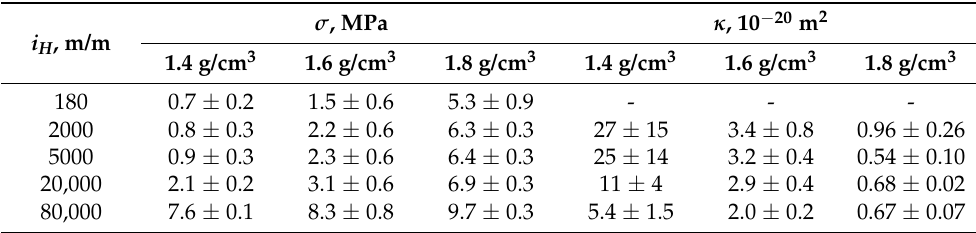
Figure 5. Total pressure at tops of permeameter cells for 10X specimens compacted to dry densities of 1.4 g/cm 3 (A1–A3), 1.6 g/cm 3 (B1–B3), and 1.8 g/cm 3 (C2, C3) and permeated by SGW at a hydraulic gradient of 80,000 m/m. Real fluid injection pressure imposed by the pump is shown in the upper graph (note that the abrupt fluid injection pressure changes were caused by short switching off the pump before weekends to disconnect cells A1–A3, preventing an overflow of burettes connected to them and after weekends, reconnecting them). Table 2. Total pressures at the top ( σ ) and permeabilities ( κ ) averaged over the last two weeks of measurement at a given hydraulic gradient ( i H ) of 10X specimens compacted to dry densities of 1.4, 1.6, and 1.8 g/cm 3 ; saturated and permeated by